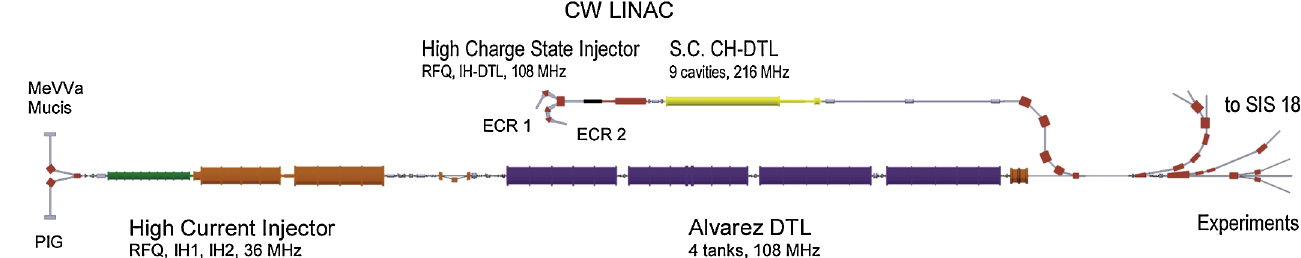
FIG. 9. (Color) Installation study of the designed cw linac in parallel to the GSI UNILAC.